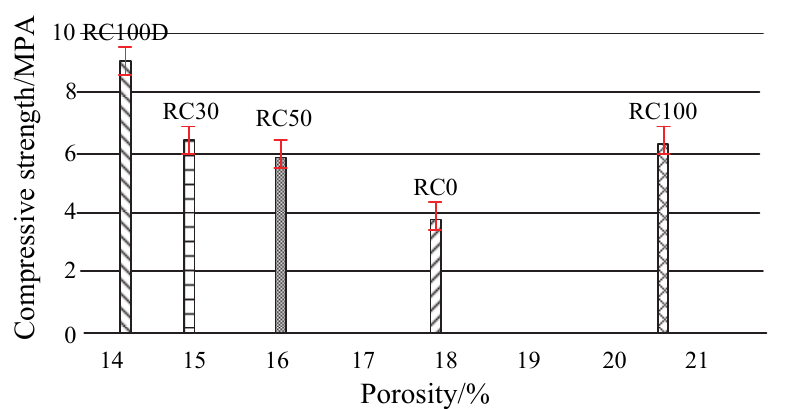
Figure 6: The diagram of the relationship between the porosity of the pervious concrete and compressive strength.